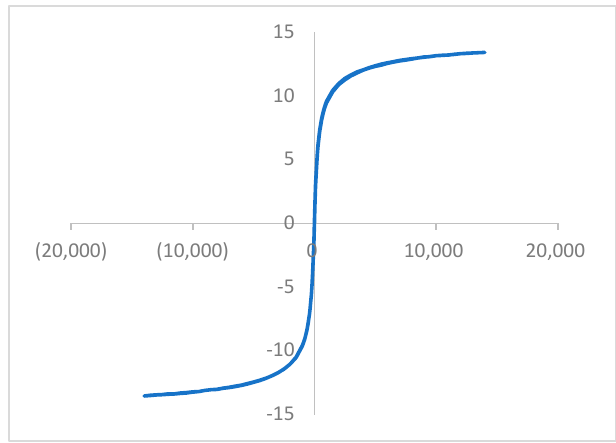
Figure 1. Magnetic saturation curve of zirconium magnetic nanocomposite.